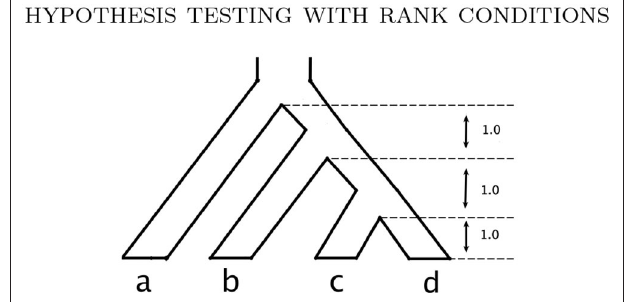
FIGURE 4 | The model species tree used for the simulations under the multispecies coalescent.